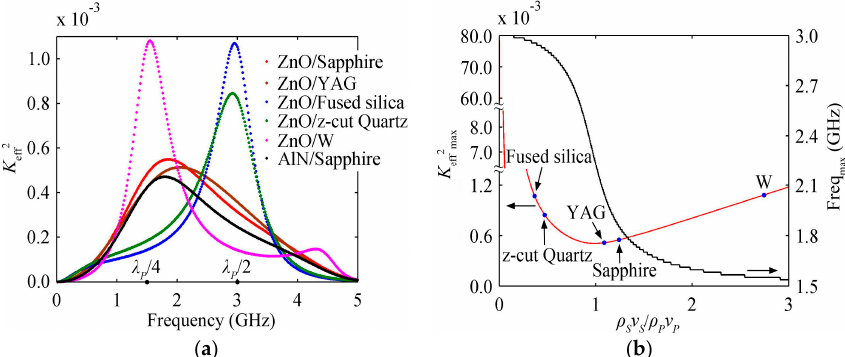
Figure 4. ( a ) The variation curve of K eff2 with resonance spectrum; ( b ) The variation curve of K eff2max and Freq max with ρ s ν s / ρ P ν P